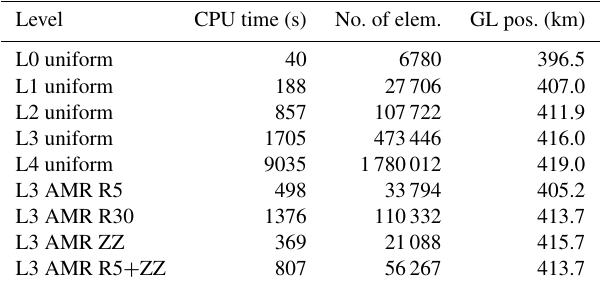
Table 3. AMR time performance comparison for the Ice1r experi- ment, MISMIP +